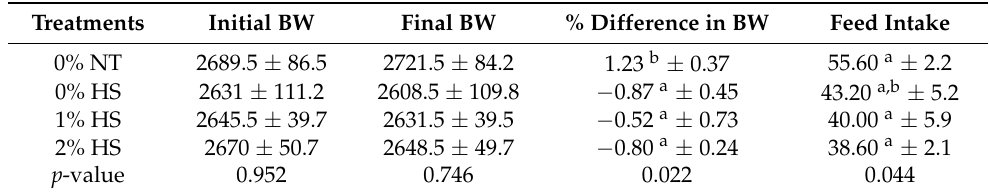
Table 1. Effects of dietary steam-exploded pine particles supplementation on the growth perfor- mances of thermoneutral and heat-stressed broiler chickens.